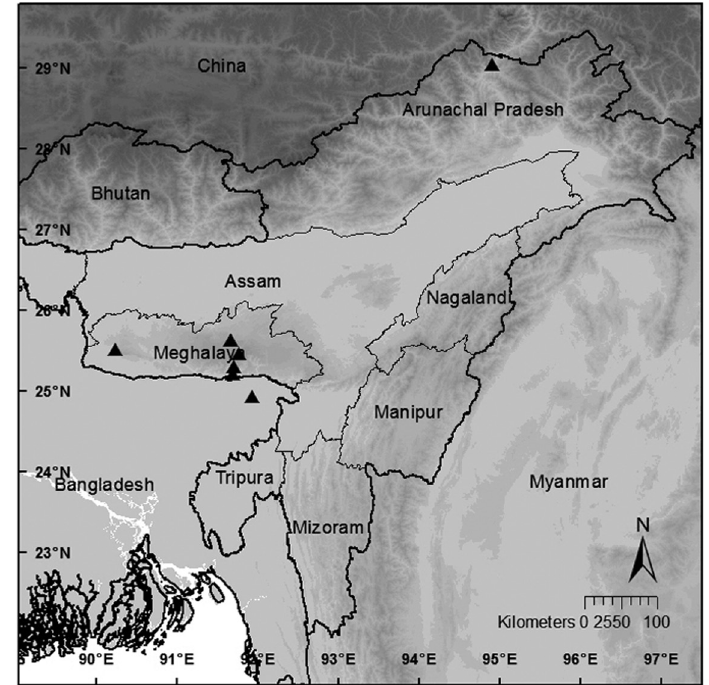
Fig. 43. Map showing the location of B. ovatifolia A.DC.